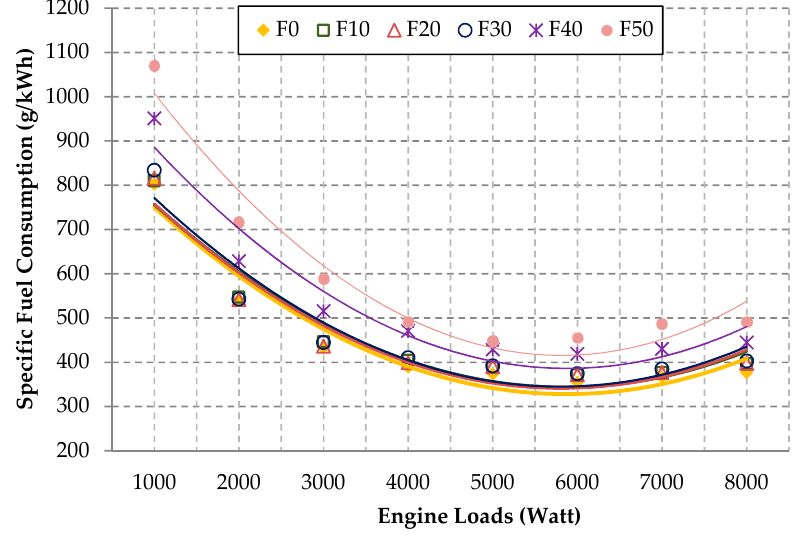
Figure 6. Specific fuel consumption changes with engine loads.